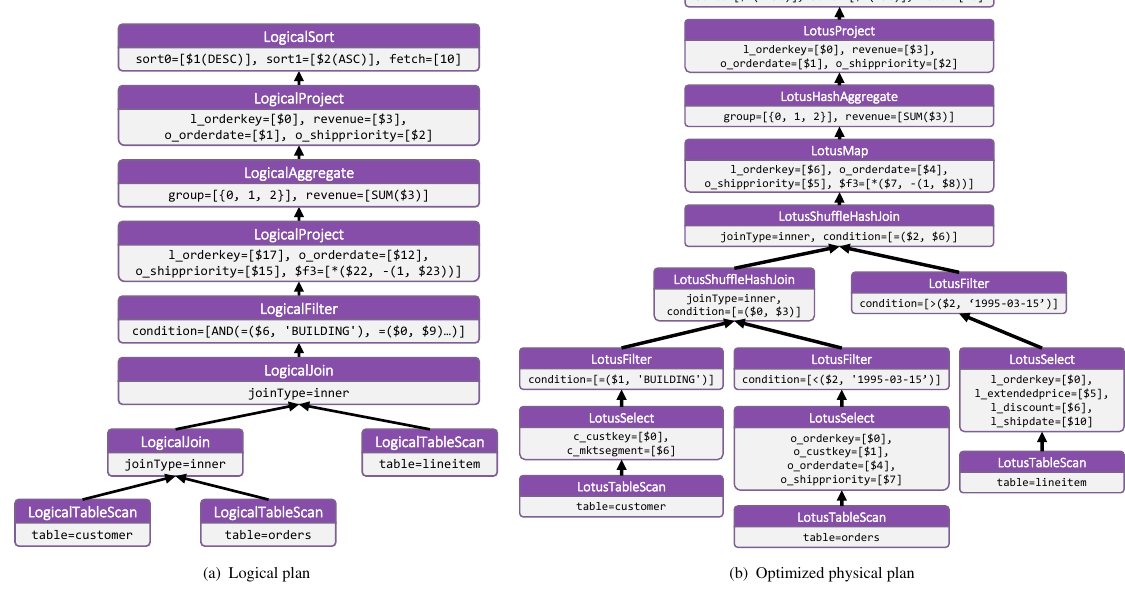
Fig. 2 Execution plans for TPC-H